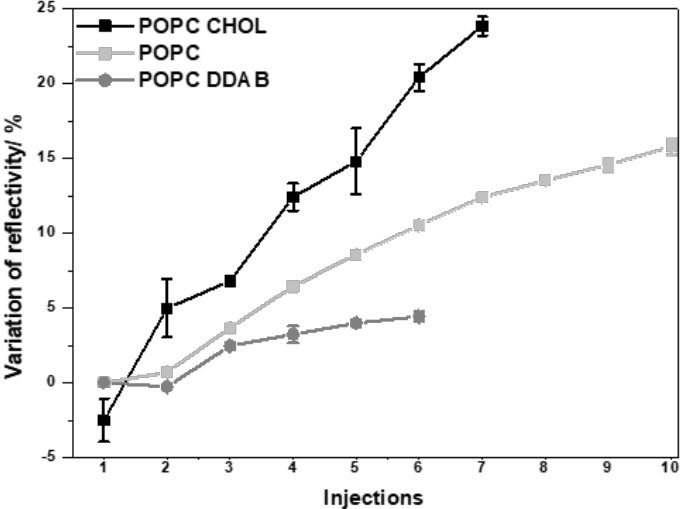
Figure 3. Variation of reflectivity in the function of the number of injections of gold NPs on POPC, POPC/DAB and PC/Chol membranes.